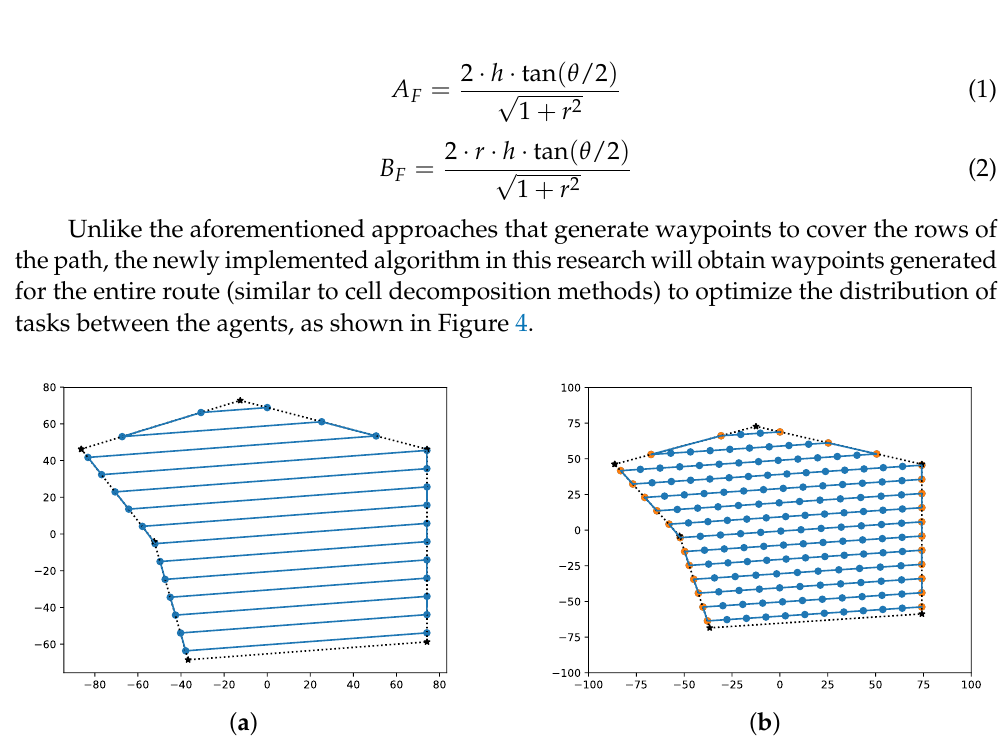
Figure 4. Waypoint generation results: ( a ) waypoints generated using simple back-and-forth algorithm; ( b ) waypoints generated with a sampled back-and-forth for our proposal.